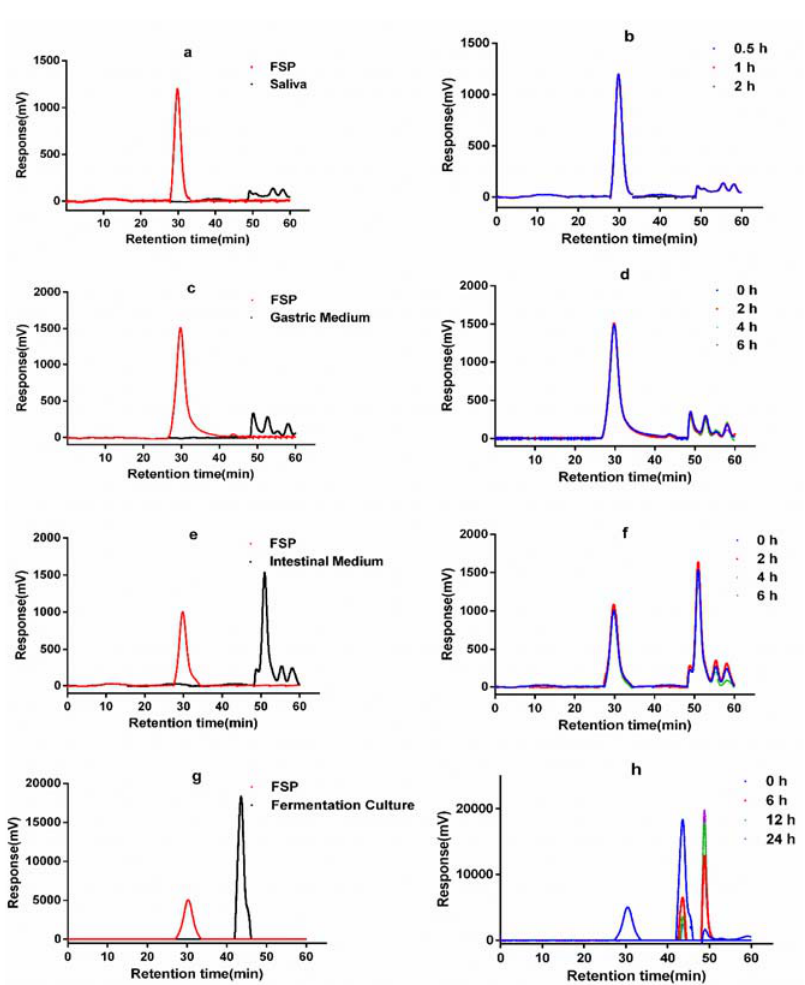
Figure 1. HPGPC chromatograms of FSP before and after saliva ( a , b ), simulated gastric ( c , d ), small intestinal ( e , f ) digestion and fermentation by human gut microbiota ( g , h ). Table 1. Reducing sugar of FSP during digestion of saliva, gastric and small intestine.